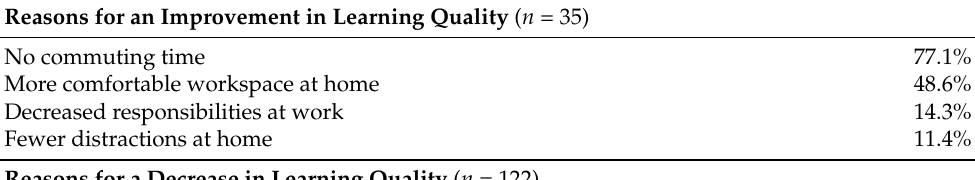
Table 5. Percent of respondents reporting a change in their quality of learning selecting particular reasons for that